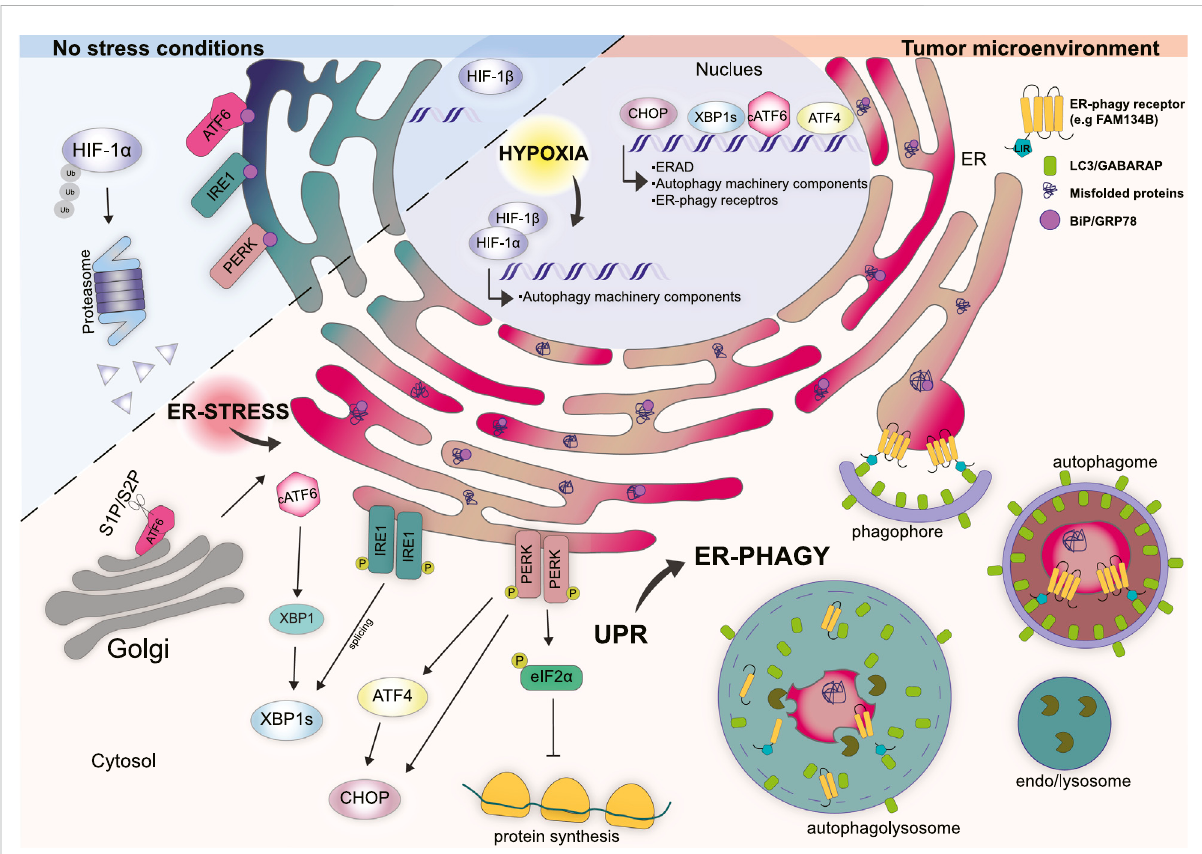
FIGURE 1 Cellular response mechanismsin non-stress conditions vs. tumor microenvironment. Under physiological conditions, HIF-1 α is localized inthe cytosol and rapidly degraded by the proteasome. The UPR stressors ATF6, IRE1, and PERK are kept inactive by the binding to the ER chaperone BiP/ GRP78. Tumor microenvironment is characterized by hypoxia which induces the translocation of HIF-1 α into the nucleus where it forms a stable complex with HIF-1 β . HIF-1 α / β complex regulates the transcription of several genes involved in the function and regulation of autophagy machinery. HypoxiaimpairsthefoldingcapacityoftheERandinducesarapidaccumulation ofmisfolded proteinsthus determiningERstress.Under ERstressconditionsBiP/GRP78bindmisfoldedproteinsanddissociatefromtheUPRsensors.ATF6translocatestotheGolgiwhereiscleavedbyS1P and S2P proteases that generate cytosolic transcription factor cATF6. cATF6 interact con XBP1 and regulates the transcription of genes involved in protein folding, traf fi cking and ERAD. Dimerization and phosphorylation of IRE1 activate the splicing of XBP1. PERK activation induces the phosphorylation of eIF2 α preventing mRNA translation. Moreover, PERK induces the transcription factors ATF4 and CHOP. In the nucleus CHOP, ATF4, and XBP1s coordinate the transcription of several genes involved in the UPR, ERAD, and autophagy-related genes including some ER-phagy receptor genes. Together hypoxia, ER stress and UPR trigger ER-phagy to restore ER